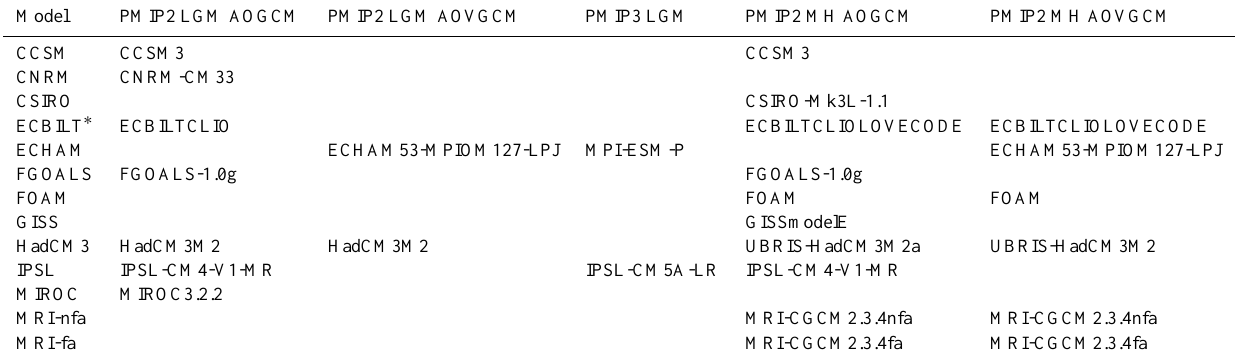
Table 1. Overview of the model versions used in the different ensembles analysed. The names correspond to the filenames in the PMIP2 and CMIP5